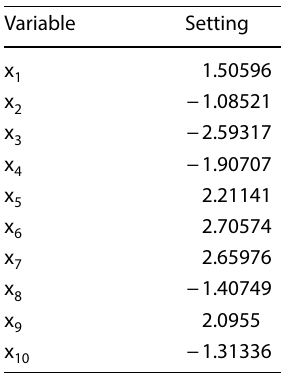
Table 15 Input settings for the second interval